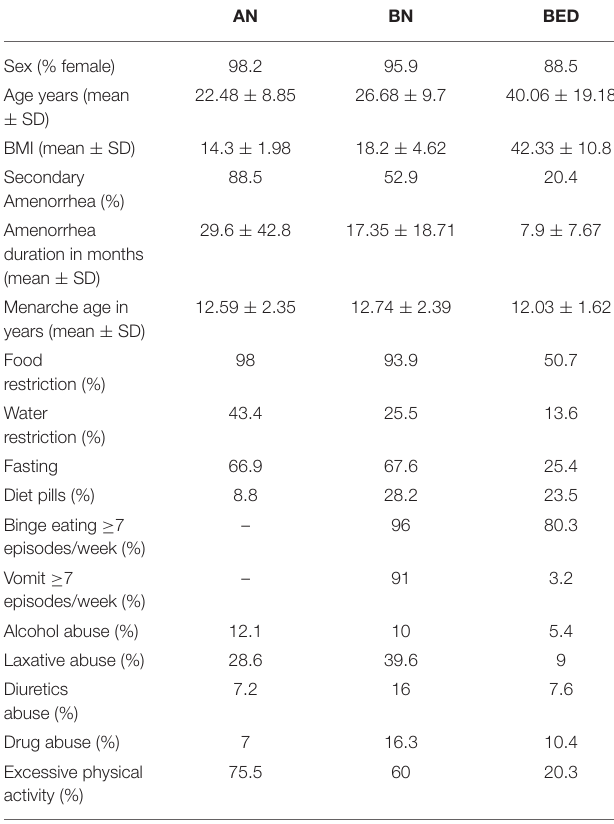
TABLE 1 | Clinical characteristics of patients with eating disorders (EDs) [anorexia nervosa (AN), bulimia nervosa (BN), and binge eating disorder (BED)] included in this